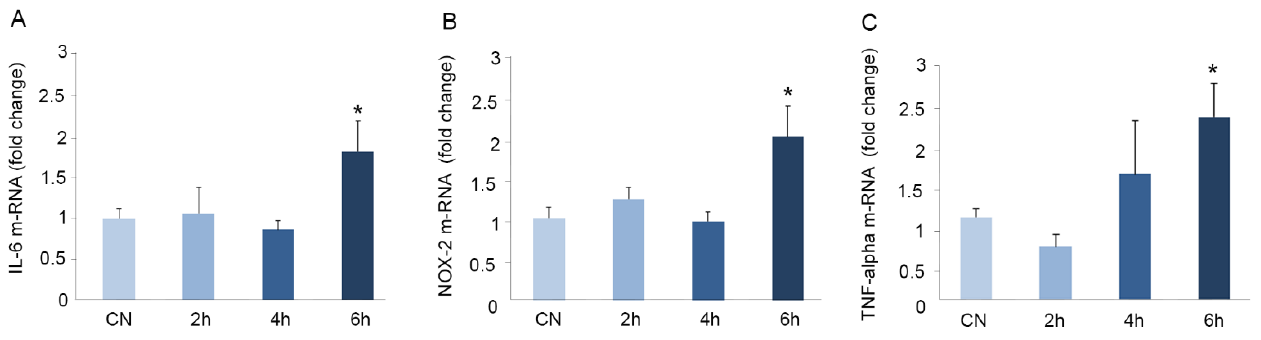
Figure 5. Immobilization causes oxidative stress in mouse brains. Mice were immobilized for different times: 0 (CN), 2, 4, or 6 h. The mRNA expression of IL-6 ( A ), NOX-2 ( B ), and TNF-alpha ( C ) were quantified by real-time (RT)-PCR. The mRNA expression was normalized with GAPDH. All data were related to that from the control and are expressed as a fold change. Values are presented as mean ± SEM from at least three independent experiments. Kruskal-Wallis test followed by Mann Whitney post-hoc test were used for statistical analysis. * p < 0.05 versus CN. Abbreviations: CN: control.